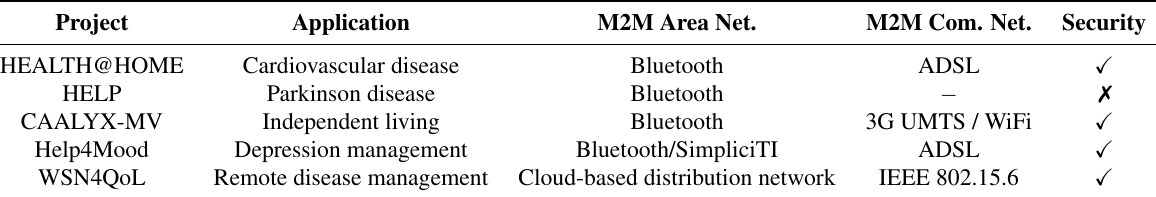
Table 5. Summary of existing projects on mHealth